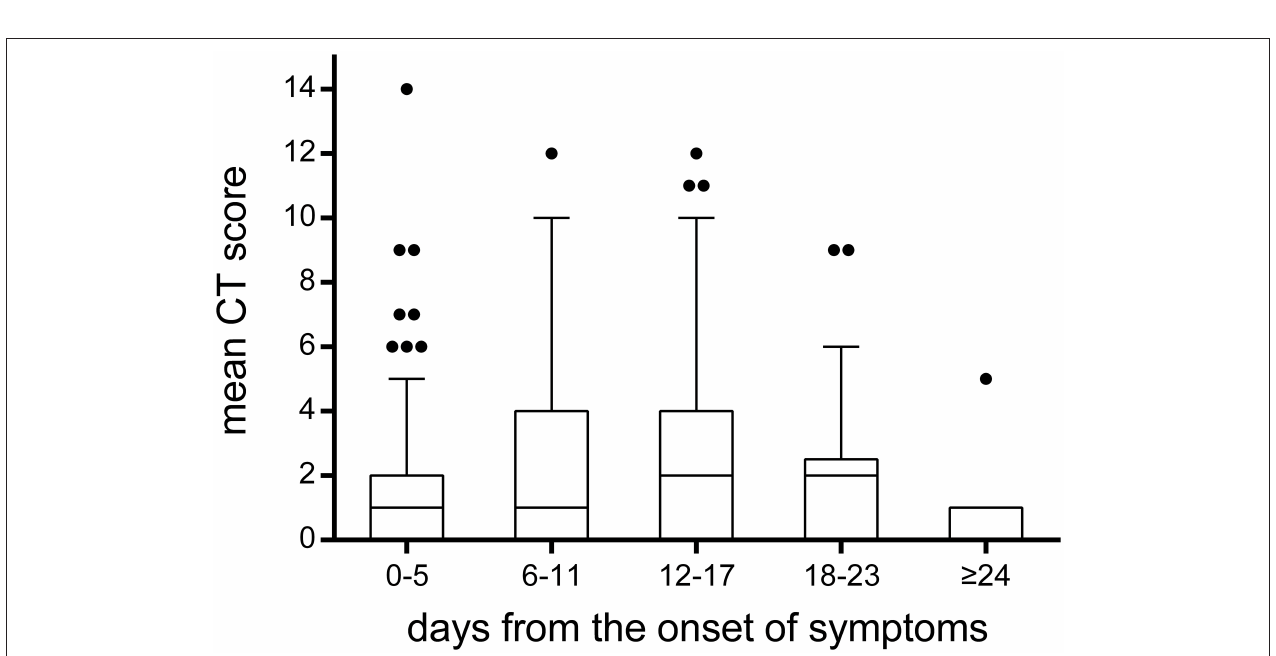
FIGURE 7 | The temporal change of CT scores on lung involvement. The CT scores on lung involvement in all chest CT scans ( n = 215). Throughout the whole duration of COVID-19 in children, the median value of CT scores was low, with a median value of 1 or 2. It was worth noting that the CT score reached 14 in one case during 0–5 days from the onset of symptoms. The bounds of the boxes represent the 25th to the 75th percentiles; the line in the middle of the box is plotted as the median. The whiskers and the outliers are drawn according to Tukey